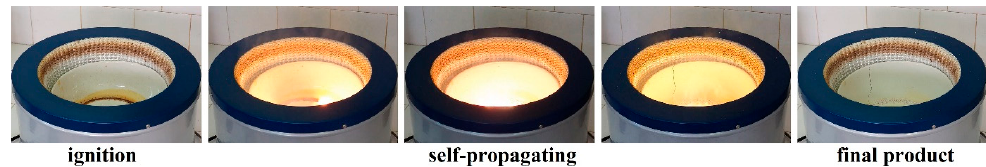
Figure 3. Images captured during the combustion reaction (sample E).